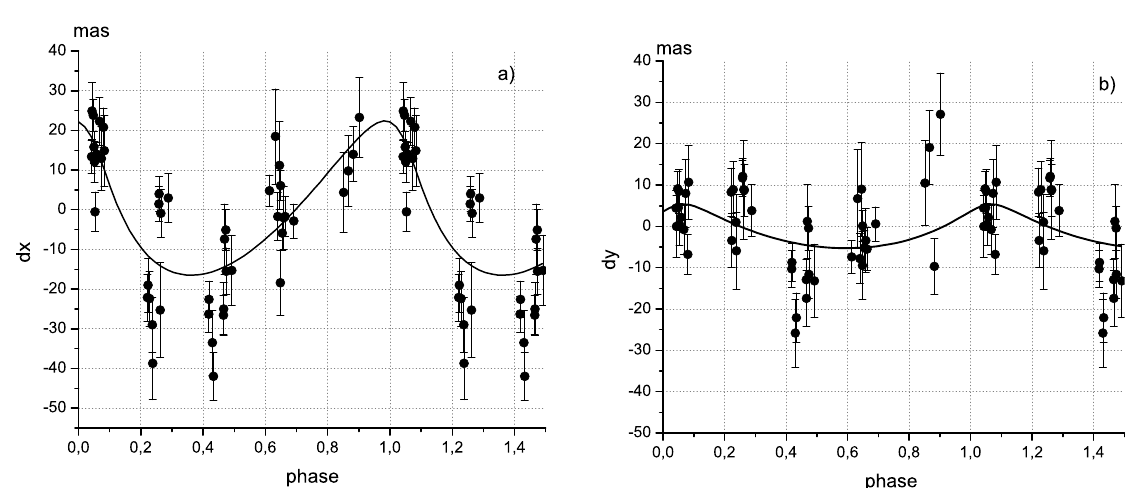
Fig. 3. ADS 9173. Comparison of the astrometric orbit Bab with CCD observations, which are presented as deviations dx(phase) (a) and dy(phase) (b) relative to the period P=4.904 years; phase=0 corresponds to T 0 = 2008.0 Notations are as follows: deviations are black circles, solid line is the ephemeris of the